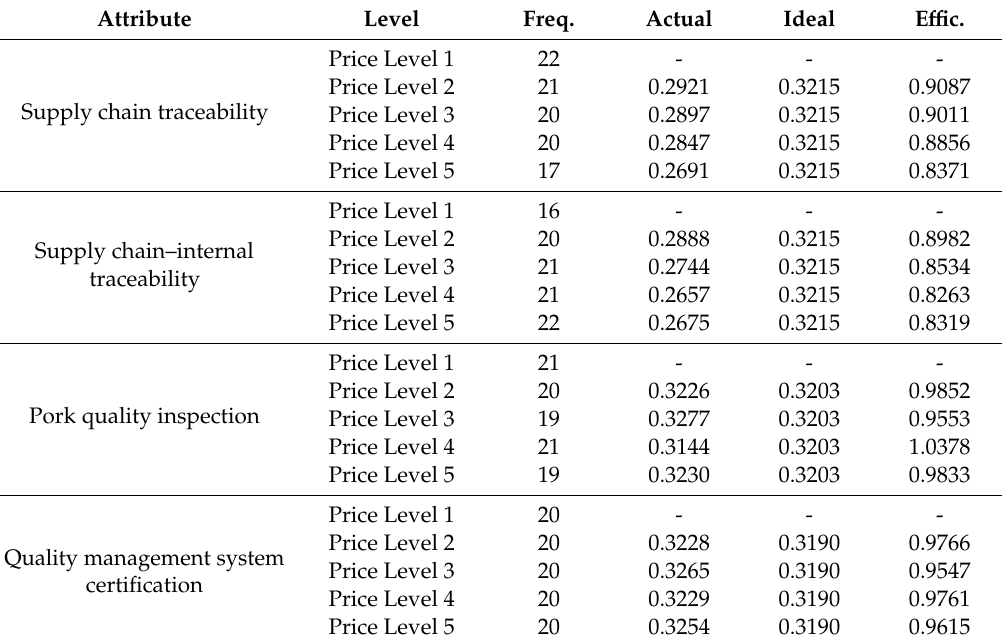
Table 4. E ffi ciency test results of the attributes and levels design.